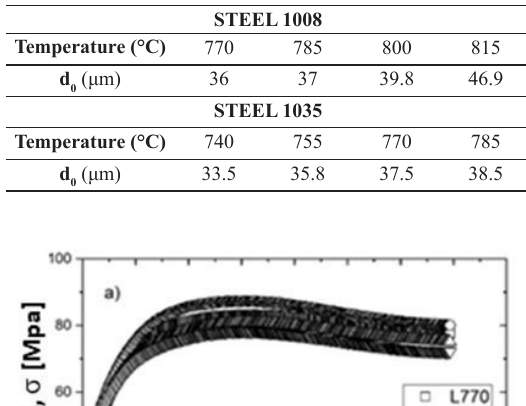
Table 6. Mean values of the grain sizes for the test